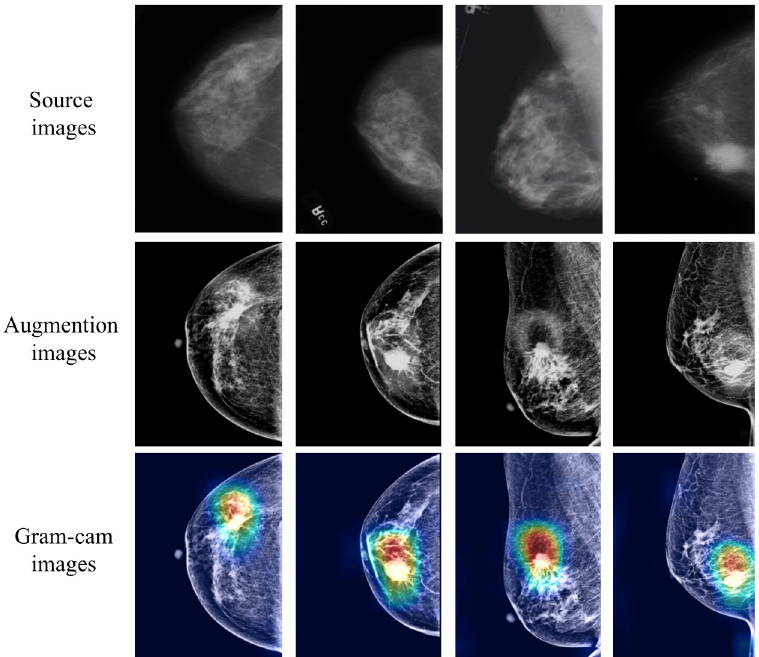
Fig 7. Gradient-weighted class activation map showing cancerous regions of breast cancer. The figure contains source data, processed enhanced images, and gram-cam images.